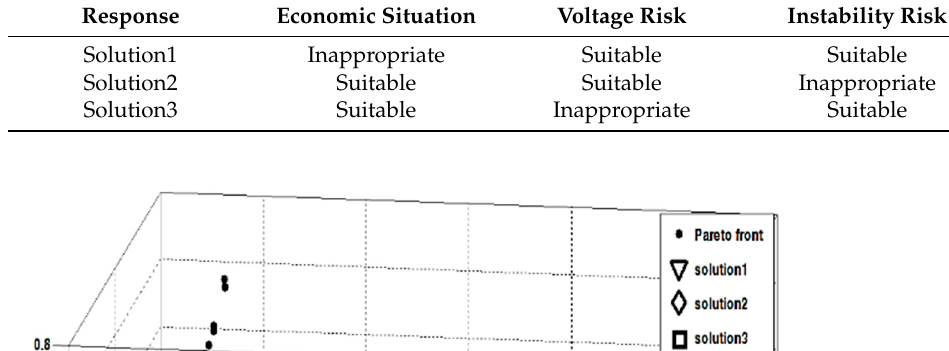
Table 3. Assumptions of the capacitance problem in the first experiment.